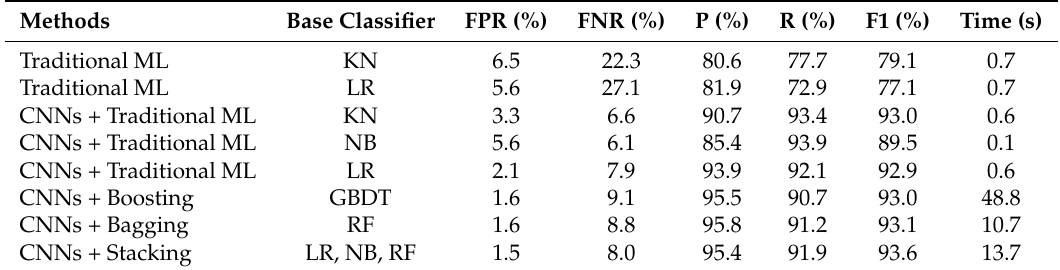
Table 5. Comparison of different classification algorithms. ML, machine learning; KN,